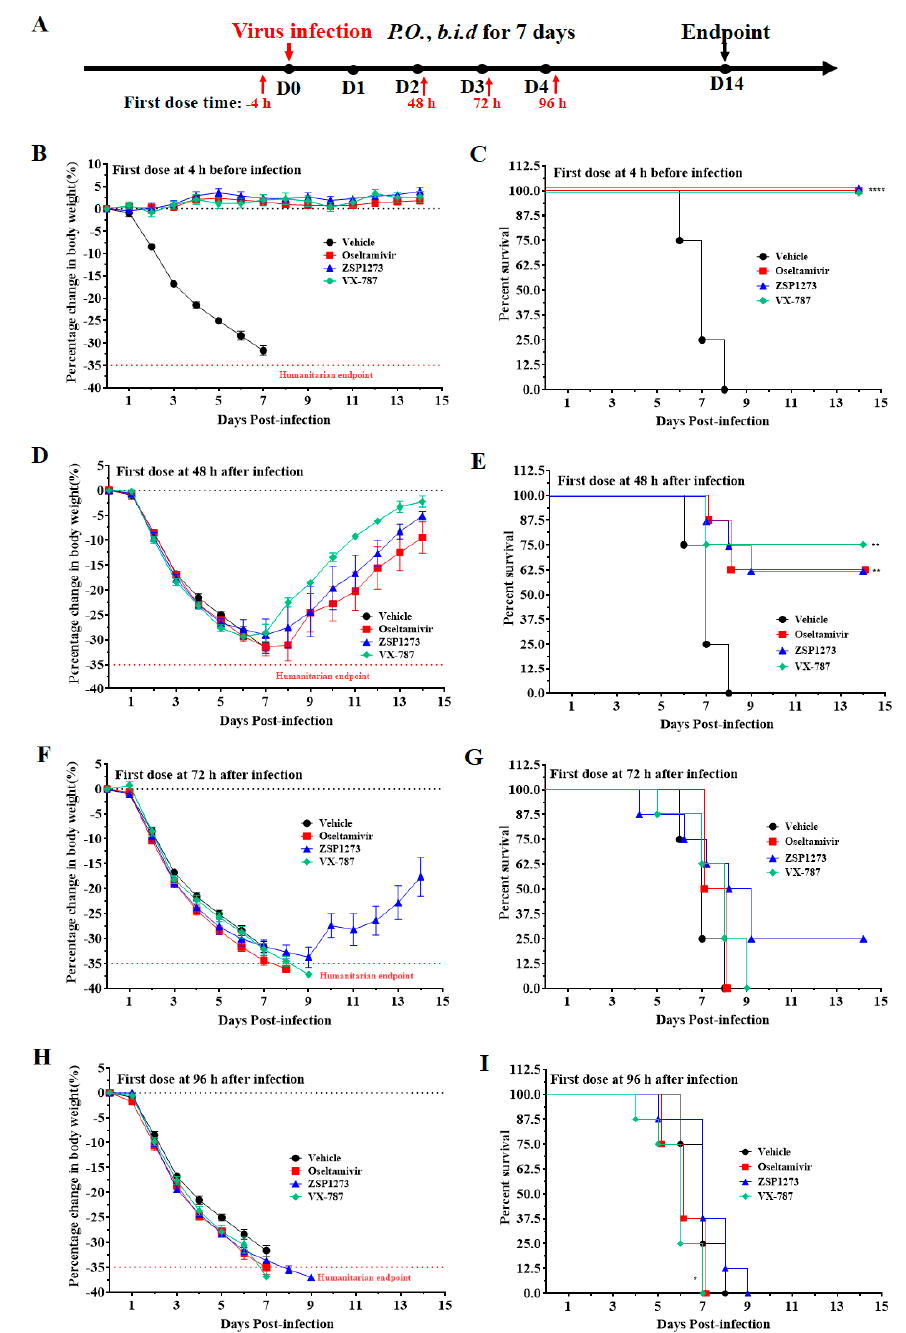
Figure 5. The antiviral activity of ZSP1273 in murine infection experiment II (n = 8, mean ± SEM): ( A ) Flowchart of the experiments: the day of H1N1 infection is defined as day 0, the first day after infection is denoted as day 1, and so forth. ( B , C ) Changes in the weight and survival rate, respectively, of mice in each group at 4 h after infection. ( D , E ) Changes in the weight and survival rate, respectively, of mice in each group at 48 h after infection. ( F , G ) Changes in the weight and survival rate, respectively, of mice in each group at 72 h after infection. ( H , I ) Changes in the weight and survival rate, respectively, of mice in each group at 96 h after infection. Based on the weight on the day of infection, a mouse with more than 35% weight loss (indicated by a red dashed line) would be considered dead, according to the IACUC. The survival analysis was performed by the Kaplan-Meier test; * p < 0.05, ** p < 0.01, **** p < 0.0001, compared with the vehicle group.